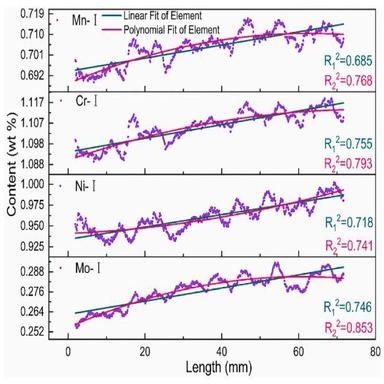
In-row content distribution of Mn, Cr, Ni, Mo for type I and fitting curve.